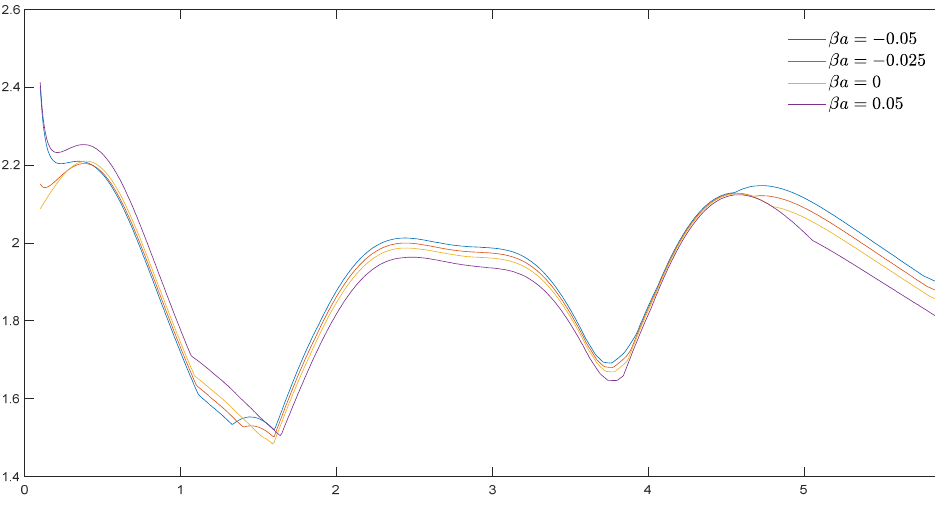
Figure 8. Maximum DSCC and incident wave number ka around elliptical opening with m = 1/6.